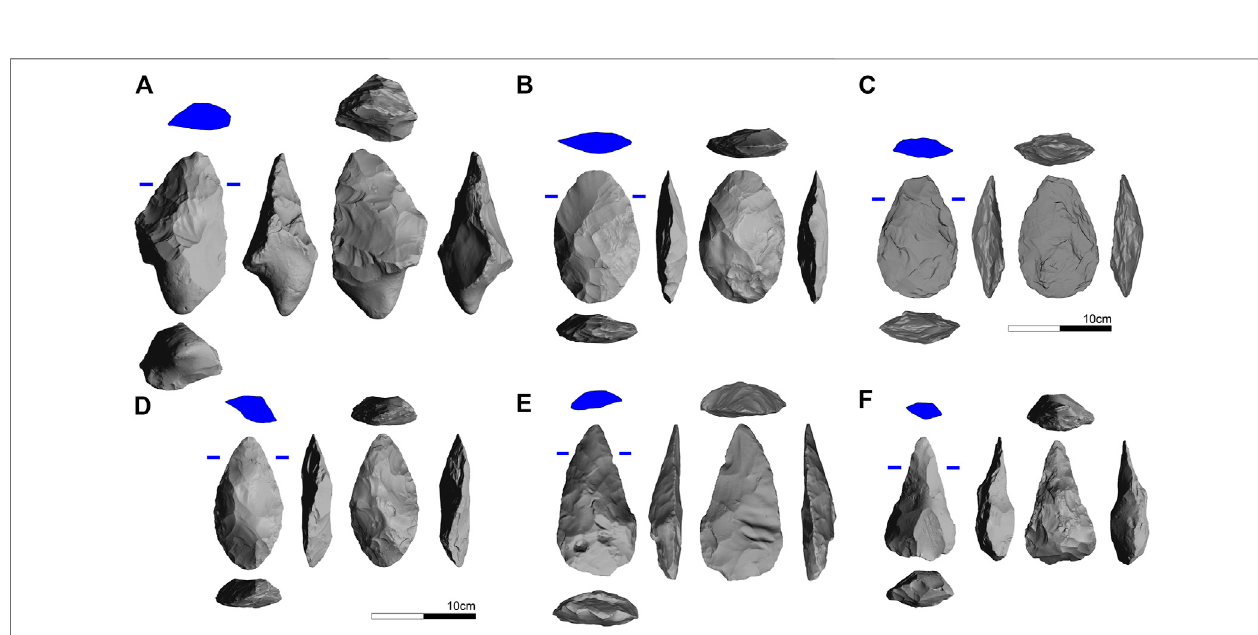
FIGURE 6 | Handaxe examples from each site: (A) , Brandon Fields (Sturge_14); (B) , Boxgrove (Q1B_Unit4_95_L1097); (C) , High Lodge (3,177); (D) , Elveden (Sturge_92); (E) , Hitchin (272); (F) Swanscombe (16). In blue, transversal sections at upper fi fth.